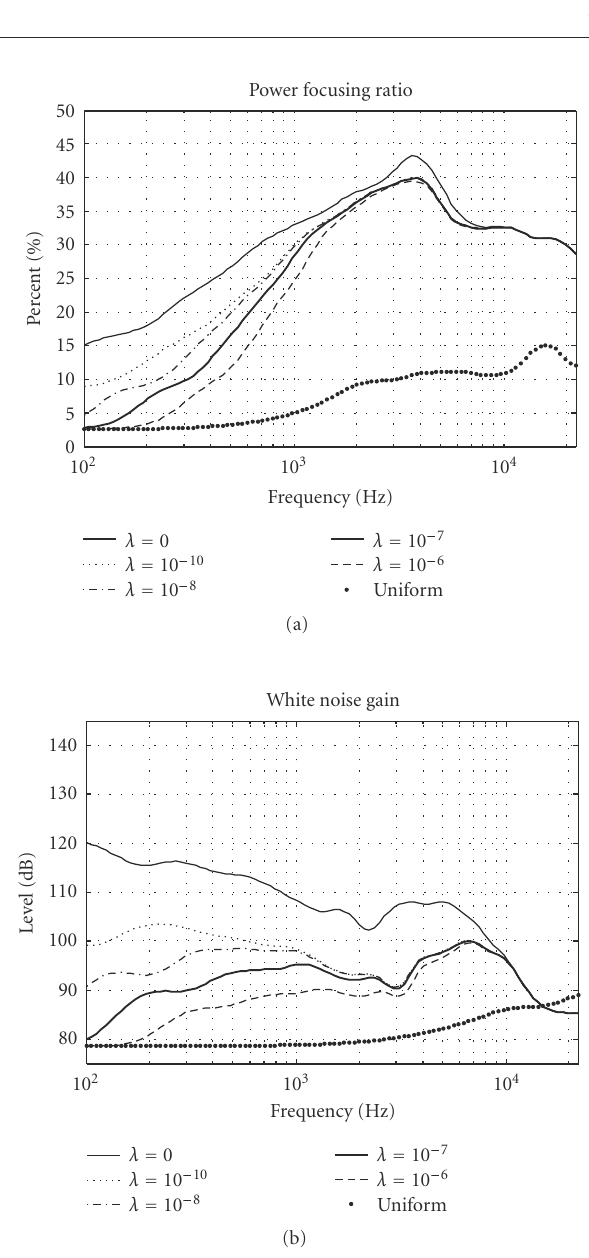
Figure 2: Power focusing ratio (PFR) and white noise gain (WNG) for several values of the regularization parameter λ and for uniform